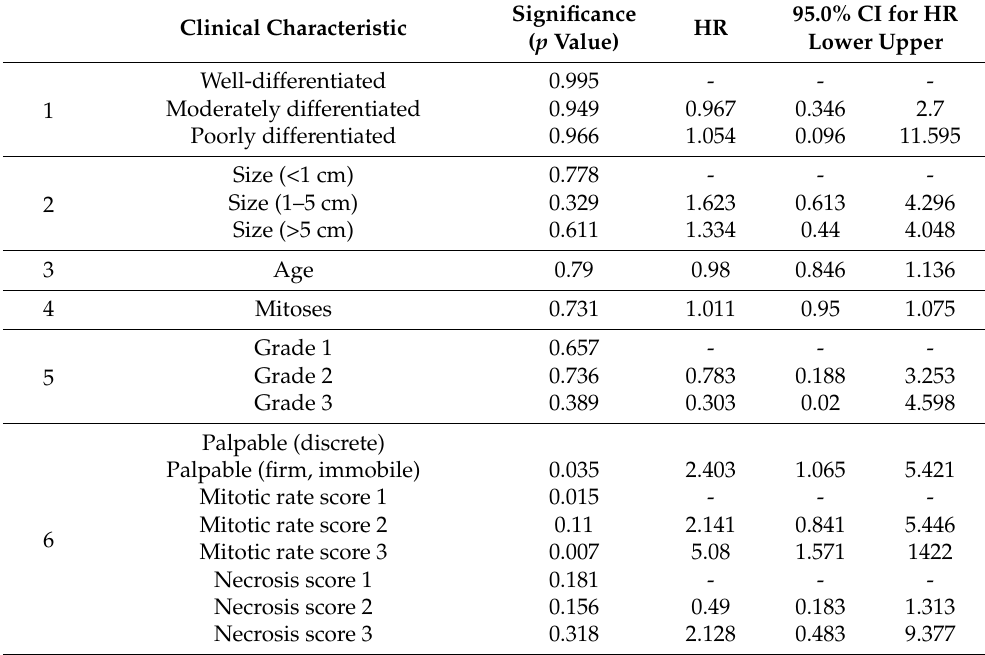
Table 2. Multivariable COX regression analysis on the Clinical_train database to identify the charac- teristics to be used in the